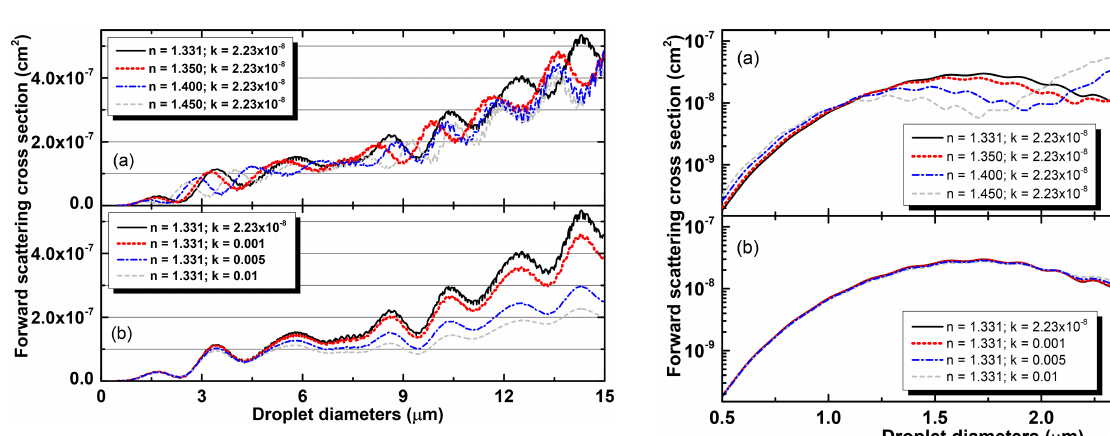
Figure 9. Enlarged view of the small-diameter range of the dia- grams of Fig. 8, with focus on the sub-3µm region. (a) Horizontal shifts no larger than 100nm may occur when the real part of the re- fractive index varies. (b) Wide variations in absorption (imaginary part of the refractive index) make almost no changes in the zoomed region of the FWSCS